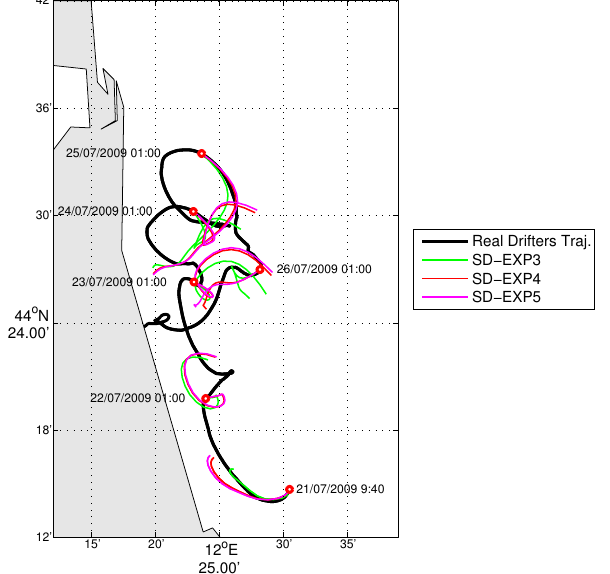
Fig. 7. Observed drifter trajectory (black lines) and the MEDSLIK- II trajectories, obtained using the surface hourly AFS currents, the first simulation starts on 21 July 2009 at 09:40UTC and lasts 15h, the next simulations start every day at 01:00UTC and last 24h: green lines are the trajectories simulated without any correction (SD-EXP3); red lines are the trajectories simulated using the AFS surface current and a wind correction of 1% (SD-EXP4) and the pink lines are the trajectories using the AFS surface currents and considering Stokes drift velocity (SD-EXP5).